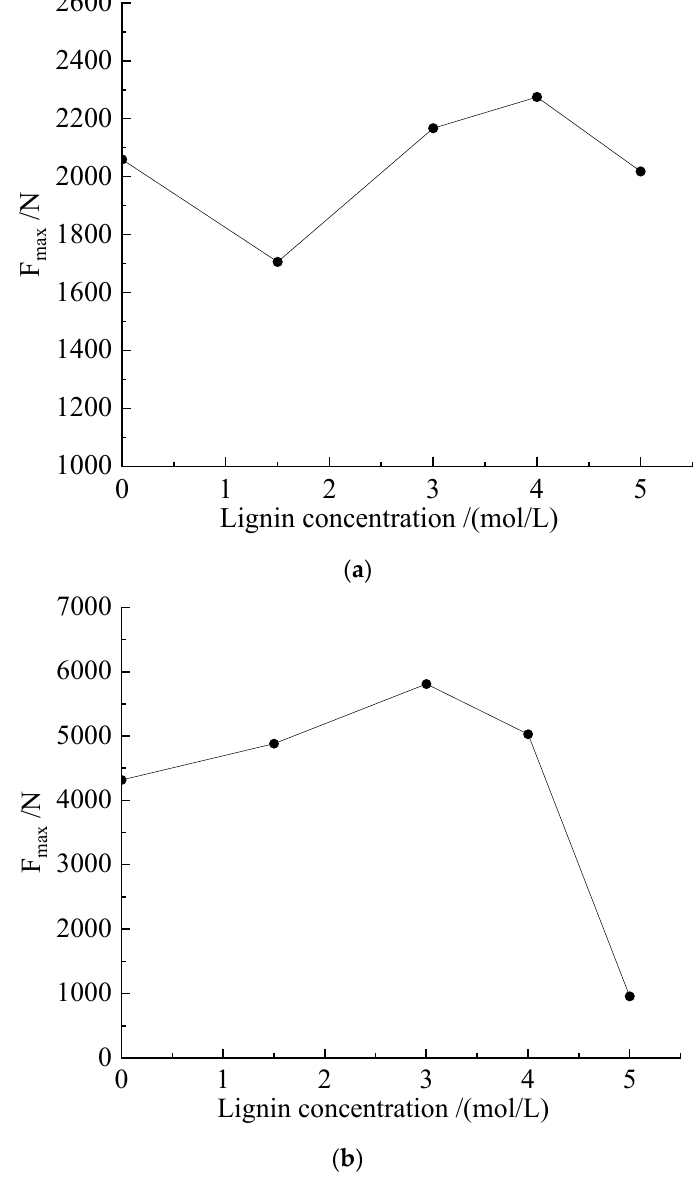
Figure 6. Lignin addition ratio and maximum axial force (F max ) of M ‐ L schemes of different samples. ( a ) Lignin addition ratio and maximum axial force (F max ) of M ‐ L scheme of constant ‐ temperature ( a ) Lignin addition ratio and maximum axial force (F max ) of M-L scheme of constant-temperature sample. ( b ) Lignin addition ratio and maximum axial force (F max ) of M ‐ L scheme of soaked sample. sample. ( b ) Lignin addition ratio and maximum axial force (F max ) of M-L scheme of soaked